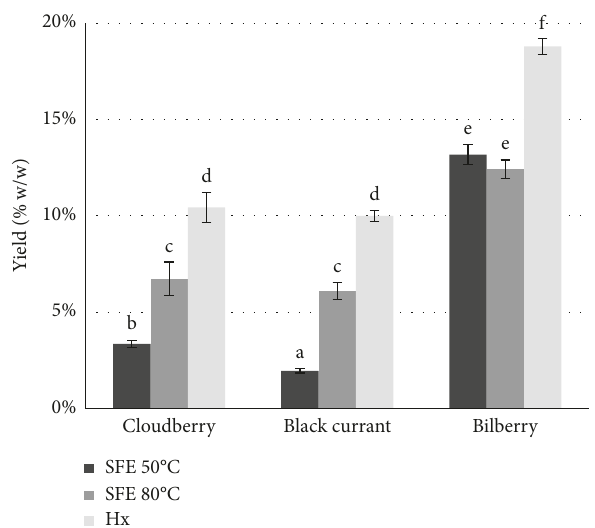
Figure 2: Extraction yield (% w/w) of cloudberry, black currant, and bilberry seed oils extracted by SFE at different temperatures and by hexane extraction. Results are mean values ± standard deviation of triplicate extractions. Different letters above error bars denote significant difference ( p < 0 . 05) according to ANOVA followed by Tukey’s post hoc